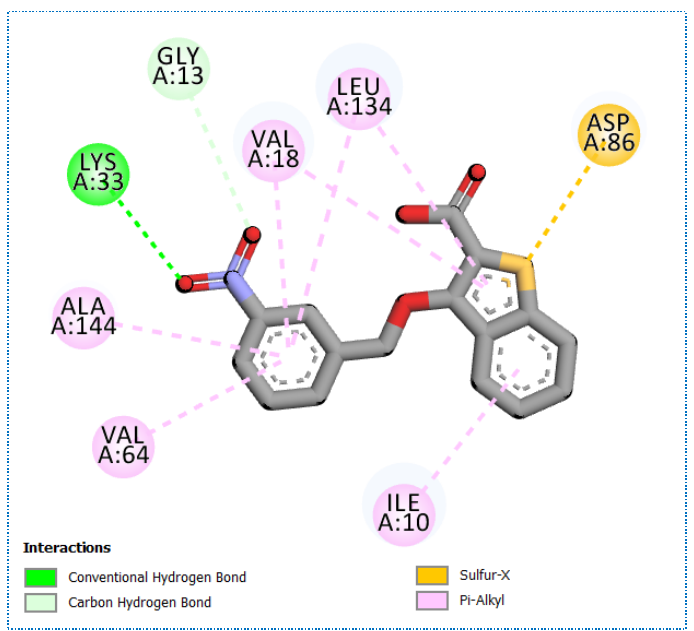
Figure 12. The 2D binding of compound 30 with cell division protein kinase 2 (PDB ID: 2wev). Compound 31 showed binding affinity equal to − 8.53 against Cyclin-dependent kinase 2 and compound 35 showed more binding affinity towards protein kinase named Eukaryotic translation initiation factor 2-alpha kinase, and its binding affinity score is − 11.812 Kcal/mol. Figure 13 show 2D binding mode of compound 35 with Eukaryotic translation initiation factor 2-alpha kinase-3. Compounds 65 and 72 revealed no potential to target kinases through the ligTMap tool.